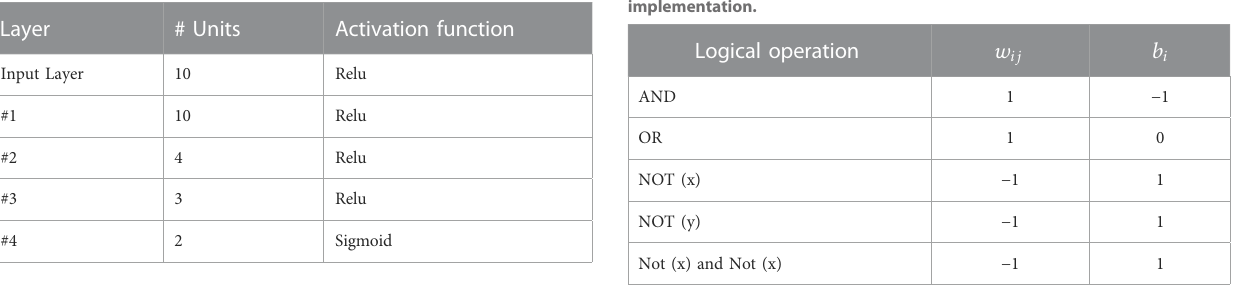
TABLE 2 Model parameters of baseline model. TABLE 3 Examples of logical operators and their corresponding